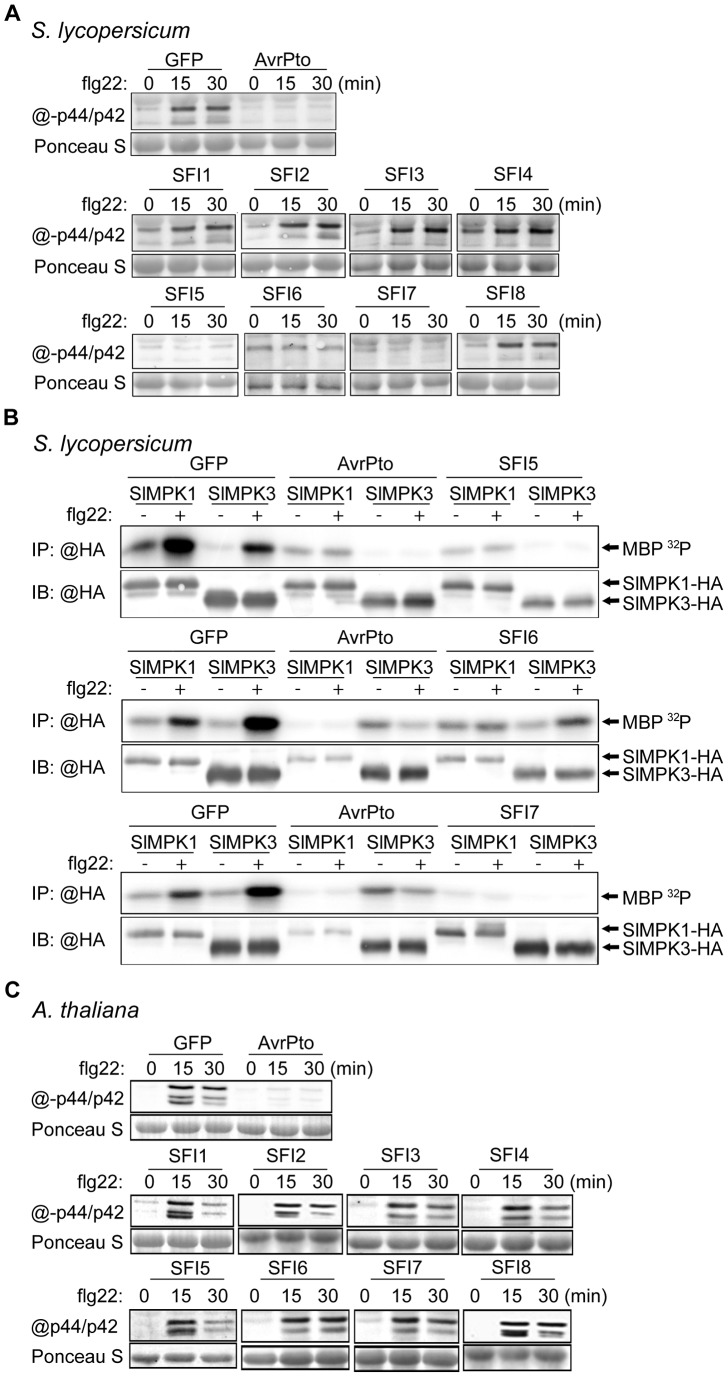
MAP kinase activation upon flg22 treatment in protoplasts expressing SFI effector genes.(A, C) Immunoblotting of phosphorylated MAP kinase in p35S-effector-transfected S. lycopersicum (A) and A. thaliana (C) protoplast samples collected 0, 15 and 30 min after flg22 treatment. Antibody raised against activated MAP kinase p44/p42 was used for detection. The experiments are representative of at least two repeats. Ponceau S staining served as a loading control. (B) MAP kinase in vitro kinase assay in S. lycopersicum protoplasts. GFP, AvrPto, SFI5, SFI6 or SFI7 were co-expressed with hemagglutinin (HA)-tagged tomato MAP kinase SlMPK1 or SlMPK3. HA-tagged MAP kinase were immunoprecipitated with anti-HA antibody for an in vitro kinase assay with [γ-32P] ATP and myelin basic protein (MBP) as phosphorylation substrate. The lower panel presents an immunoblot with anti-HA antibody showing the expression of HA-tagged proteins. The upper panel shows an autoradiography visualizing MBP phosphorylation (MBP 32P) in the presence of immunoprecipitated MAP kinase. The experiment was repeated twice with similar results.